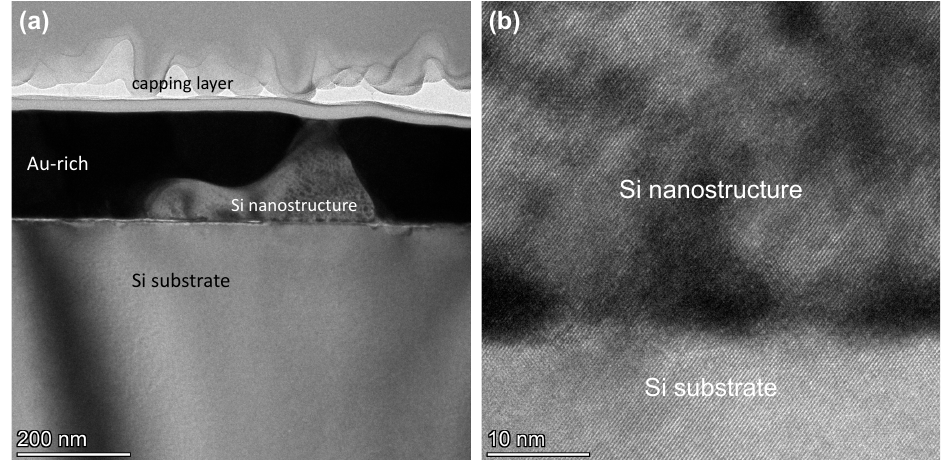
Figure 9. ( a ) A cross-sectional TEM image showing the formation of a Si nanostructure. ( b ) A higher resolution TEM image of the formed nanostructure showing its epitaxial relationship with the underlying Si substrate.